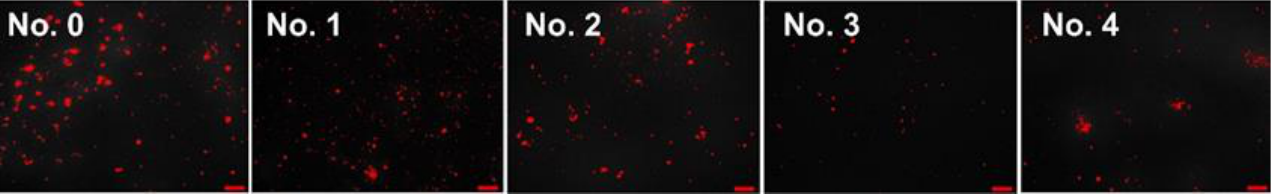
Figure 4. Images of the micro-organisms attached to specimens No. 0 – 4.